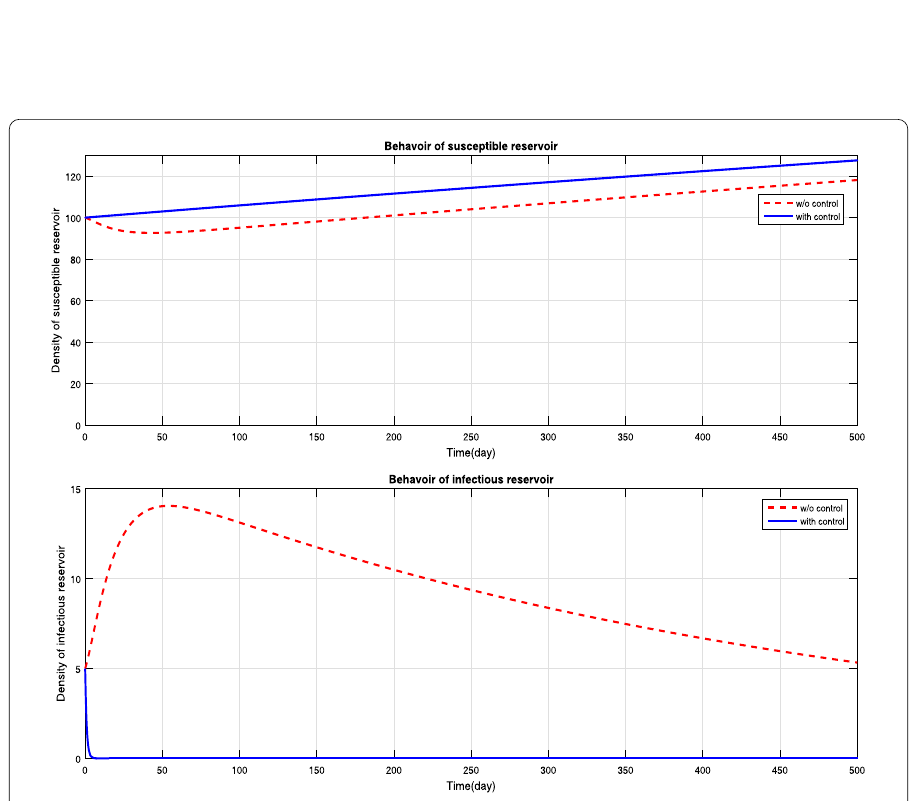
Figure 10 Comparison of behaviors with and without control in case of S r and I